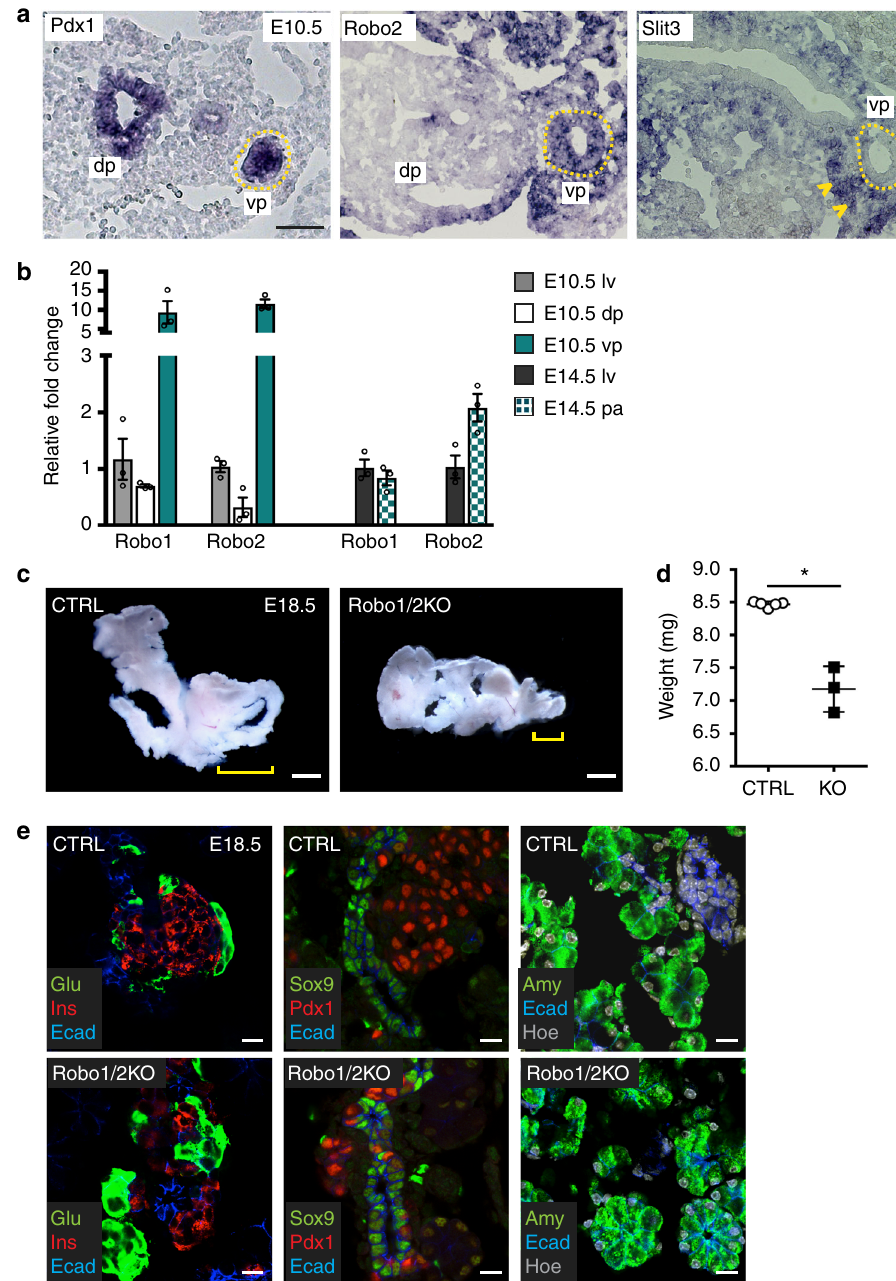
Fig. 1 Robo genes control pancreas organ growth. a In situ hybridisation analysis of Pdx1 , Robo2 and Slit3 on E10.5 mouse cryosections. Yellow dotted lines demarcate ventral pancreatic epithelium; yellow arrowheads indicate Slit3 expression in the surrounding pancreatic mesenchyme. dp dorsal pancreatic bud, vp ventral pancreatic bud. Scale bar, 100 µ m. b Quantitative RT-PCR (RT-qPCR) analysis of Robo1 and Robo 2 expression in mouse liver and pancreas at E10.5 (left) and E14.5 (right). Data represent mean ± s.e.m.; n = 3. c Pancreas gross morphology at E18.5. Yellow brackets indicate the head of the pancreas. Scale bars, 1 mm. d Quanti fi cation of pancreas weight in control (CTRL; n = 5) and Robo1/2 KO (KO; n = 3) E18.5 mouse embryos. Error bars represent ± s. e.m. *Two-tailed Student ’ s t -test P < 0.05. e Immuno fl uorescence (IF) analysis of Glucagon (Glu), Insulin (Ins), E-cadherin (Ecad), Amylase (Amy), Sox9 and Pdx1 on CTRL and Robo1/2 KO E18.5 mouse pancreatic cryosections. Scale bars, 20 µ